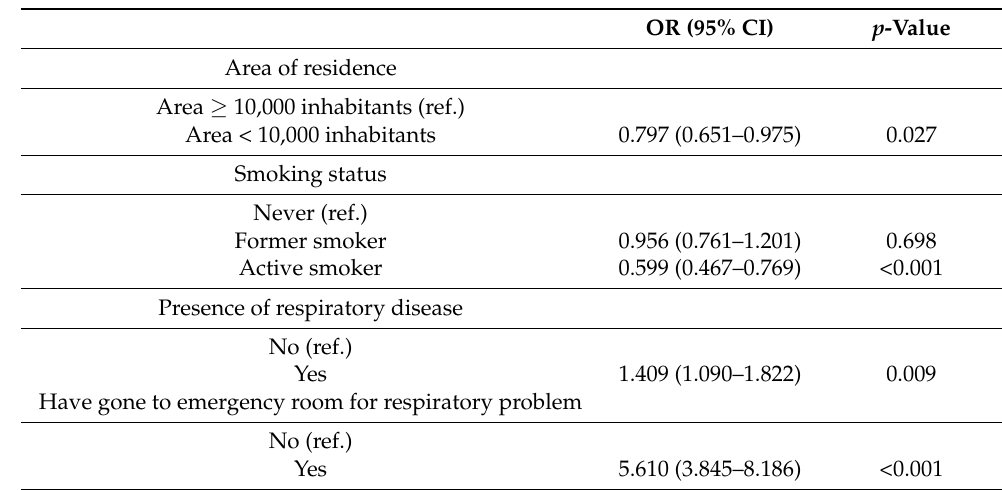
Table 3. Factors associated with seeking medical attention among those interviewed with respiratory symptoms. Multivariate